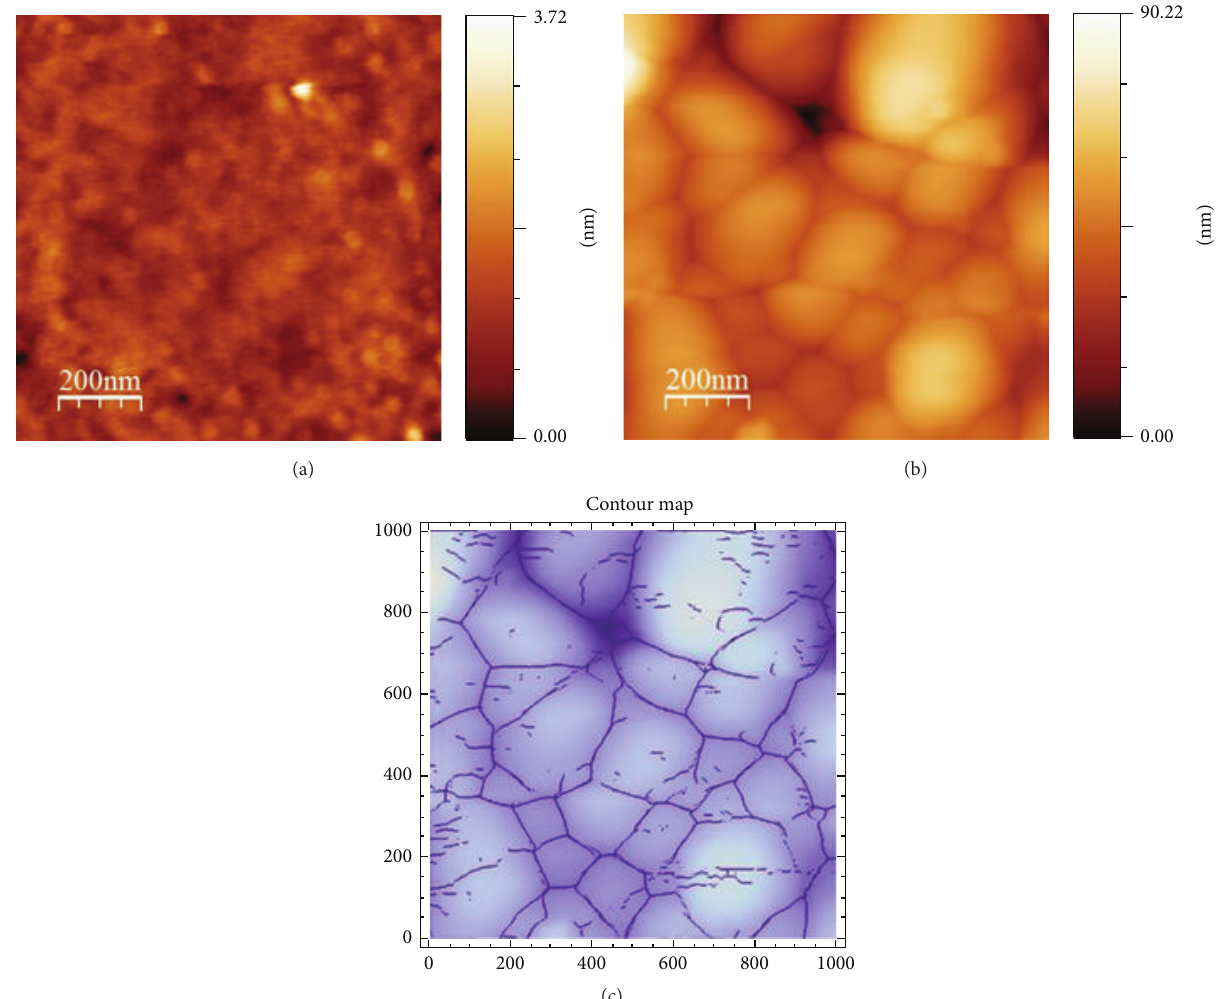
Figure 4: AFM images of the CdS film deposited onto MWCNT/PSF substrate. (a) Two-dimensional image of 1 𝜇 m × 1 𝜇 m of the MWCNT/PSF polymeric substrate (without film), (b) two-dimensional image of 1 𝜇 m × 1 𝜇 m of the CdS film deposited by CBD, and (c) contour map with the grain boundaries traced by the home-built algorithm implemented in “Mathematica” to calculate the mean grain size of the CdS.